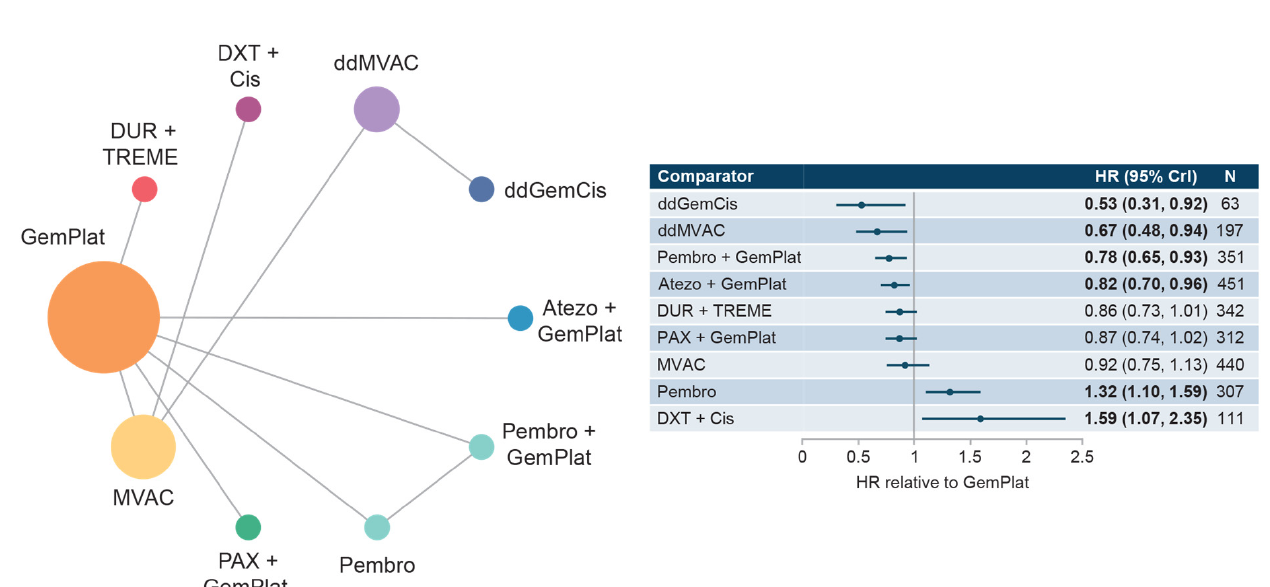
Figure 4. Network diagram and HR for PFS by treatment network for the cis-eligible/mixed network.